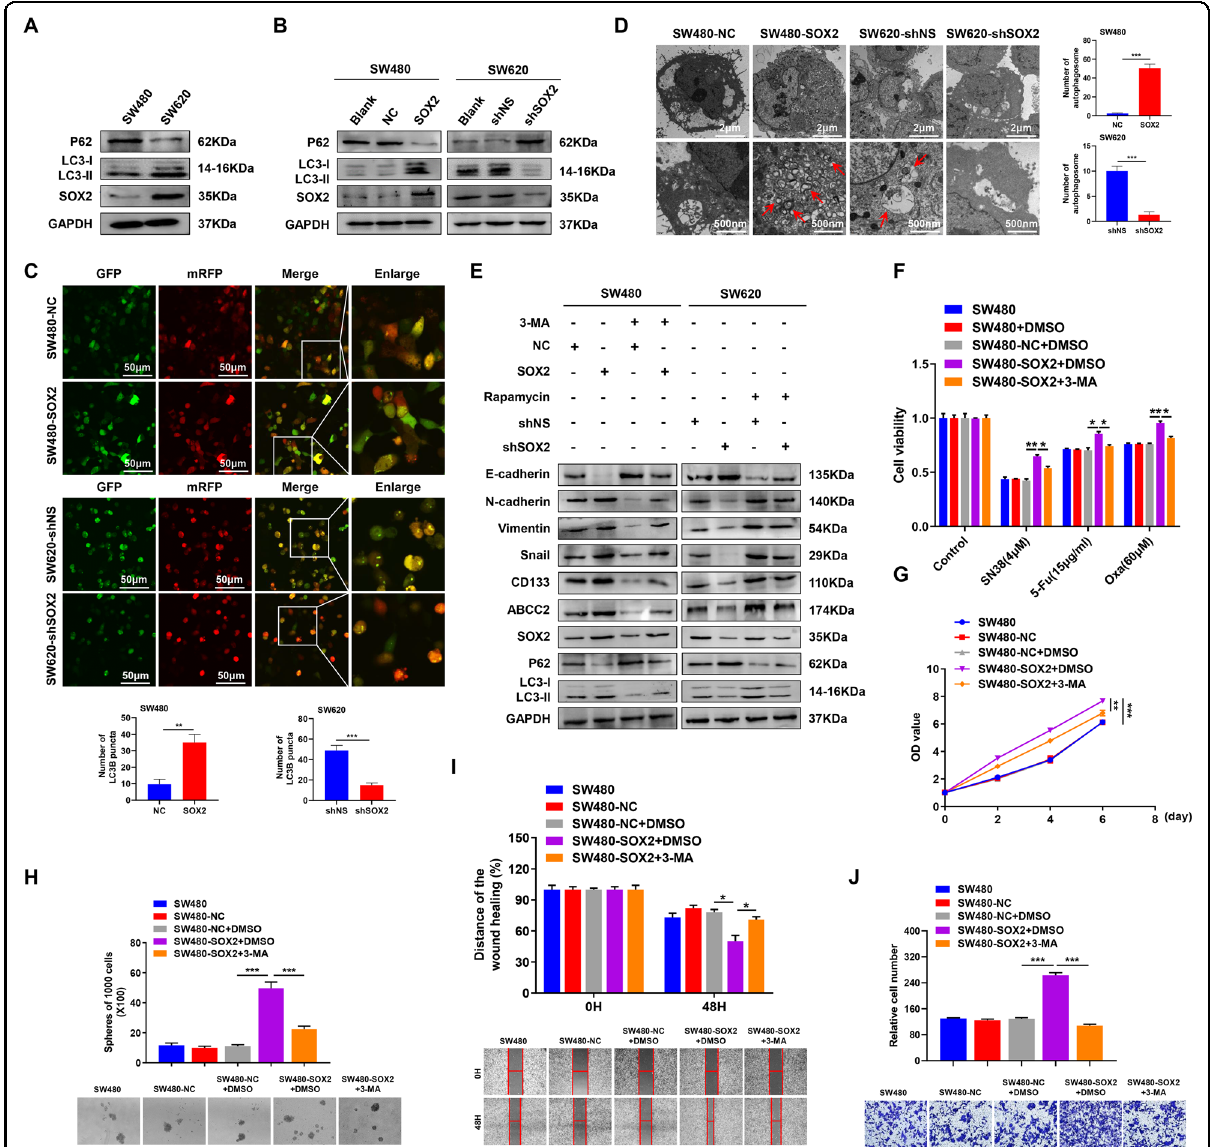
Fig. 3 Autophagy is involved in SOX2-induced chemoresistance, CSCs properties, and EMT in CRC. A , B Western blot analysis of LC3II/LC3I and P62 expression in SW480 and SW620 cells ( A ) as well as in SW480 and SW620 transfected with SOX2 clone or SOX2 shRNA ( B ). C SOX2- overexpressing SW480 cells or SOX2-de fi cient SW620 cells were transiently transfected with mRFP-GFP-LC3B adenovirus for 6 h, then the number of LC3B puncta was analyzed by confocal microscopy. D Transmission electron microscopy was utilized to assess the number of autophagic vesicles in SW480 and SW620 cells transfected with SOX2 clone or SOX2 shRNA. Red arrows indicated autophagic vesicles. E SW480 or SW620 cells transfected with SOX2 clone or SOX2 shRNA were treated with 3-MA (10 mM) or Rapamycin (50 nM) for 24 h, then western blot was performed with indicated antibodies. F – J The ability of chemoresistance ( F ), proliferation ( G ), stemness ( H ), migration ( I ), and invasion ( J ) in SOX2-overexpressing SW480 cells treated with 3-MA was examined by drug sensitivity assay, cell viability assay, tumor sphere formation assay, wound healing assay, and transwell invasion assay. Experiments were conducted in triplicate. Data are shown as mean ± SEM. * P < 0.05, ** P < 0.01, and *** P <